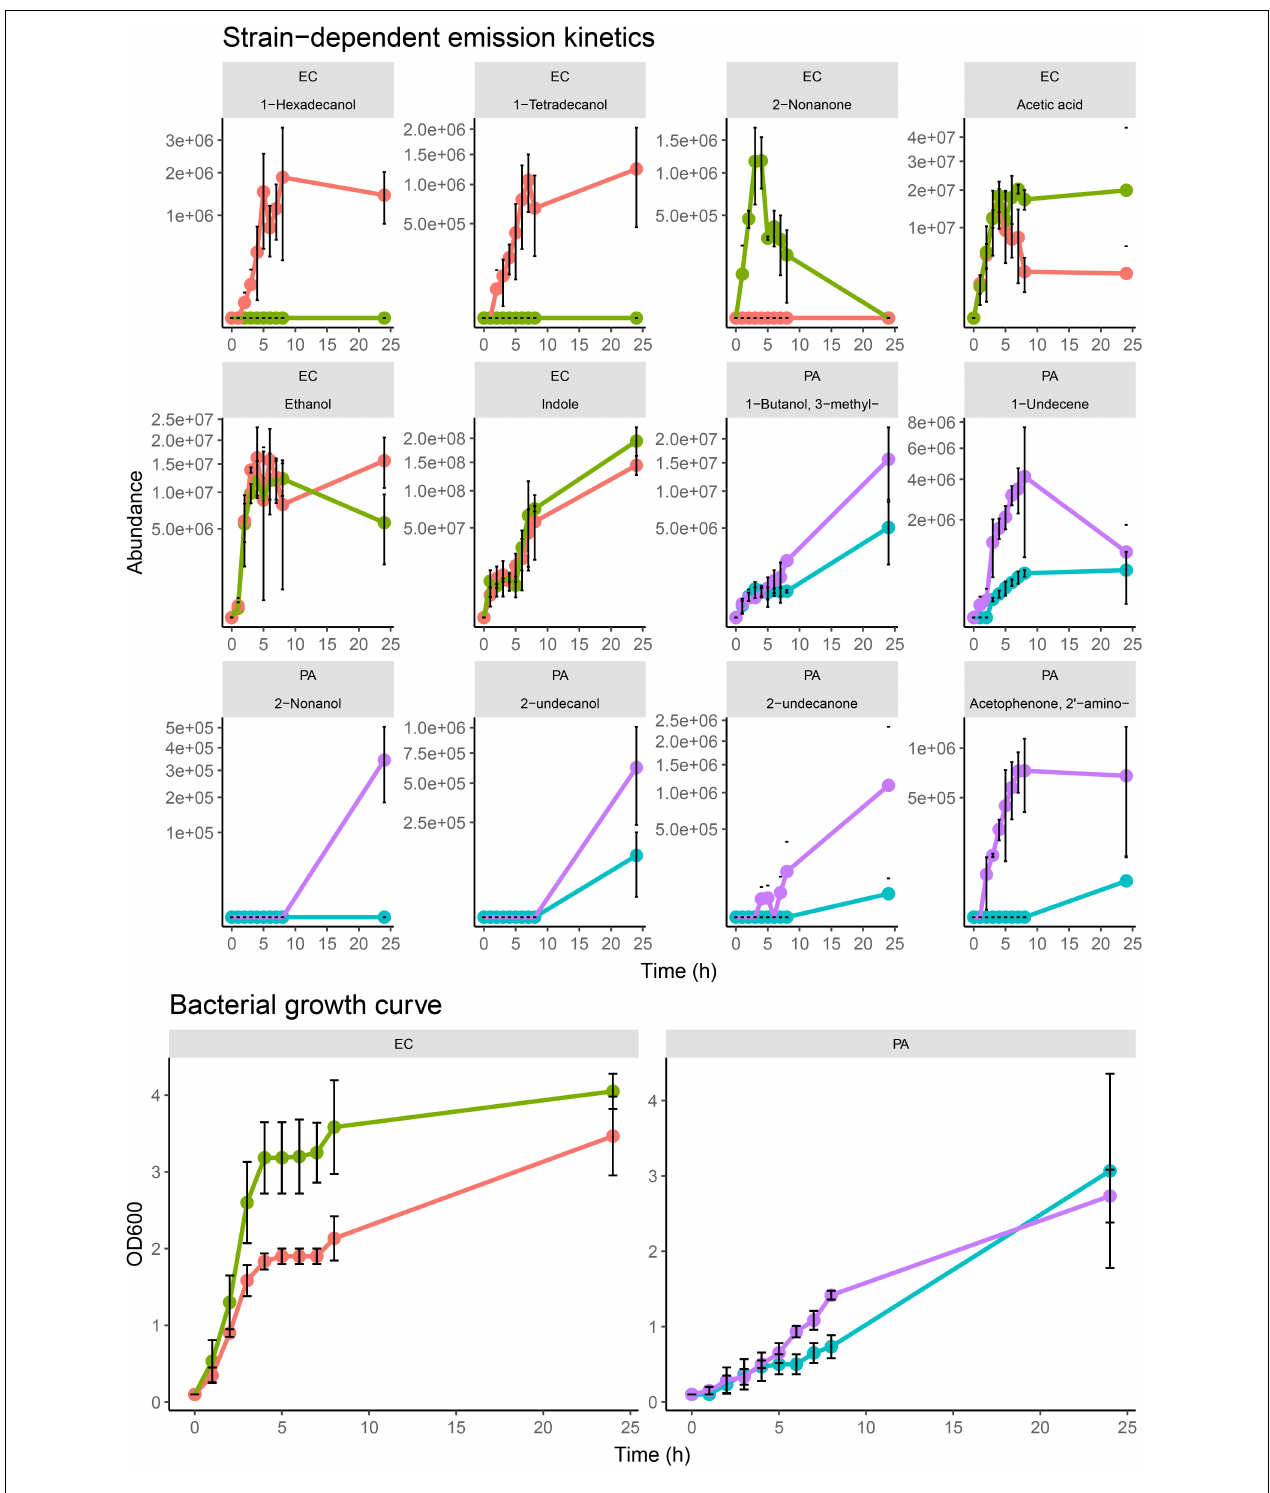
FIGURE 4 | Kinetic profiles of strain-dependent emission from EC.A, EC.B, PA.A, and PA.B (for all examined strains, n = 3) for selected compounds sampled at specific phases of growth of bacterial samples in TSB growth media. Error bars represent the standard deviation around the mean abundance values. Y-axis labels on all VOC kinetic plots are scaled by square root. Corresponding cell growth curves based on OD 600 measurements measured from each replicate at the respective sampling time. The corresponding strain names to the abbreviated titles of the bacterial samples shown in this plot are as follows: EC.A: E. coli DSM103372, EC.B: E. coli DSM30083, PA.A: P. aeruginosa DSM105372, PA.B: P. aeruginosa DSM25642.